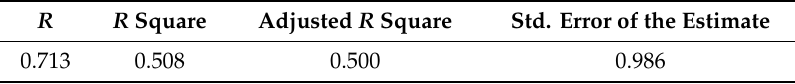
Table 8. Model summary of the developed MLR model.